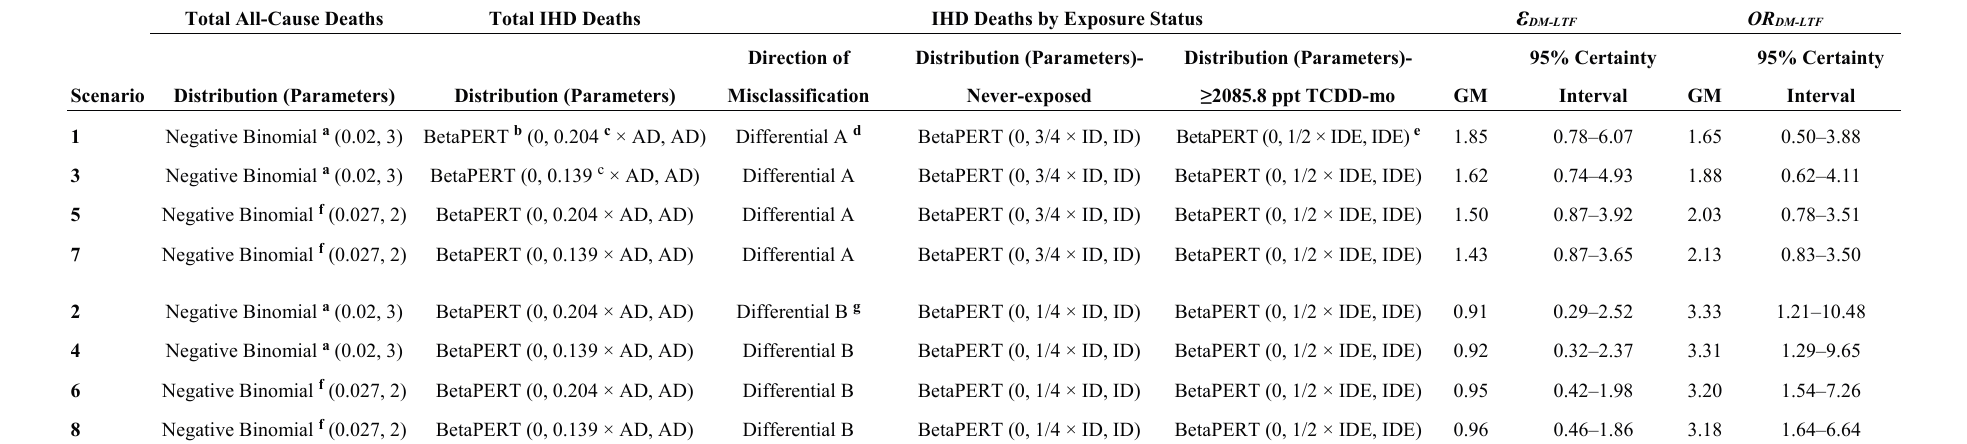
Table 2. Bias-analysis scenarios: description of probability distributions for classification parameters used to estimate the number of workers lost to follow-up that could have died from IHD and corresponding geometric mean errors ( bias-analysis certainty